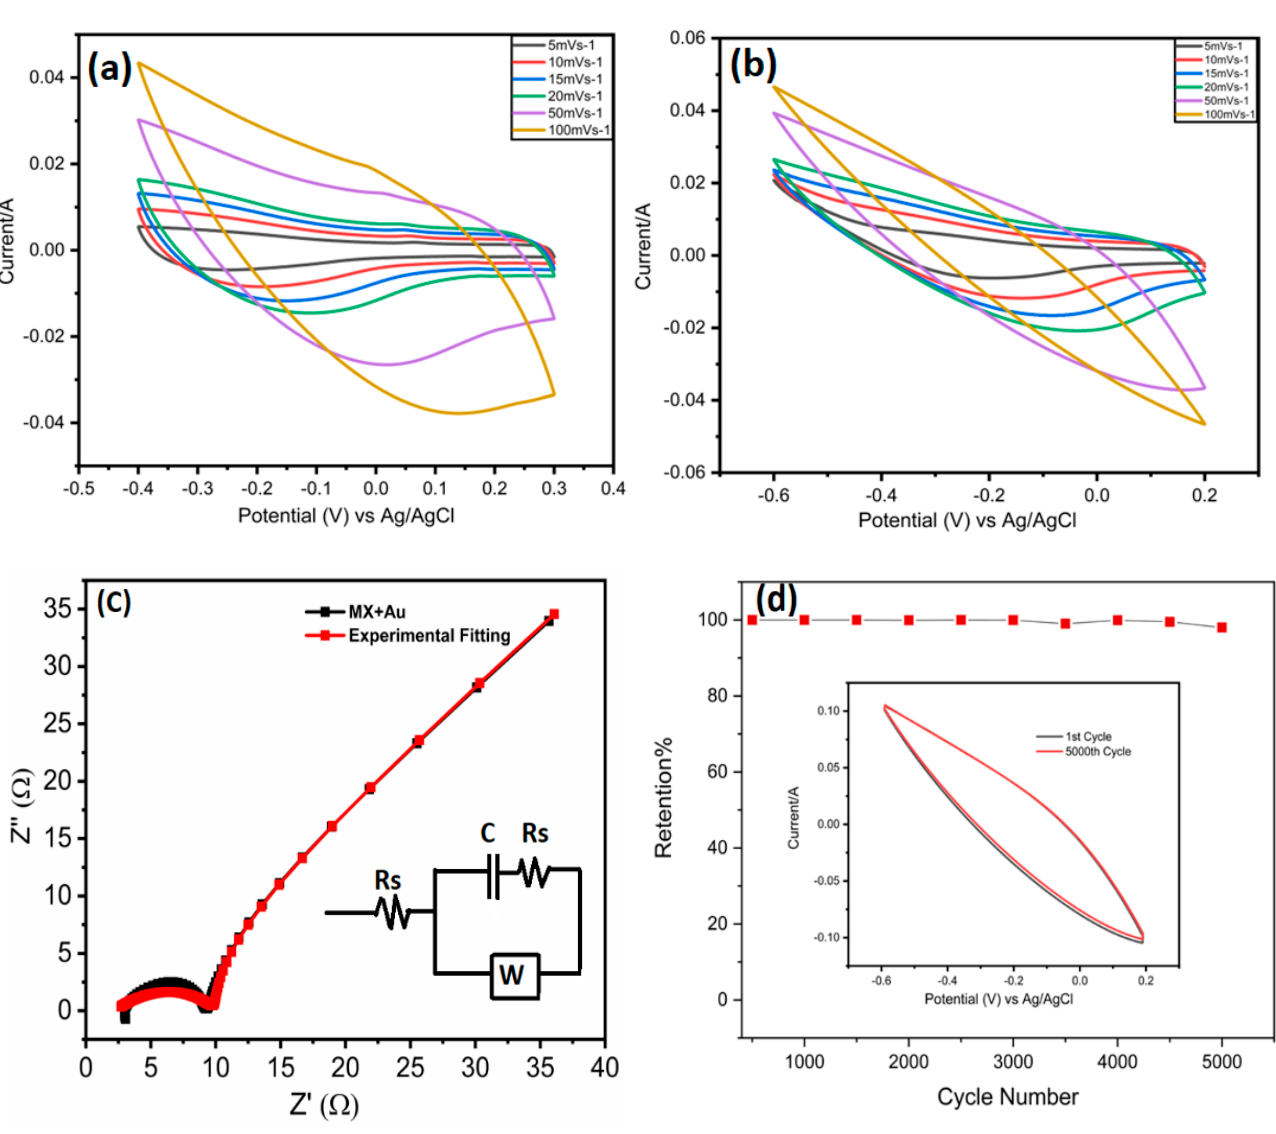
Figure 5. ( a ) CV curves of MXene at different scan rates in 3-electrode setup; ( b ) CV curves of MX/AuNPs in 1 M H 2 SO 4 at different scan rates in 3-electrode setup; ( c ) Nyquist plots of MX/AuNPs, Inset shows the equivalent circuit model for the Nyquist plots; ( d ) MX/AuNPs electrode showing excellent cyclic stability with 98% capacitance retention at 100 mVs − 1 1M H 2 SO 4 after 5000 cycles. The CV curves of pure MXene at various scan rates (5 mVs − 1 to 100 mVs − 1 ) in the voltage range of 0.3 to − 0.4 V (vs. Ag/AgCl) are shown in Figure 5a. At 5 mVs − 1 , MXene electrodes had a gravimetric capacitance of 383.5 Fg − 1 . The CV profiles did not show an- odic or cathodic peaks, indicating that the MXene’s electrochemical charge storage process could be the dominating mechanism. However, as illustrated in Figure 5b, the addition of HAuCl 4 significantly raised the MXene gravimetric capacitance by blocking MXene sheet restacking and assisting in the ion intercalation process. Therefore, the greater d-spacing can be attributed to the overall improvement in charge storage performance by minimiz- ing the restacking that would cause reversible (de)intercalation. The MX/Au electrode in three setups has been tested in 1 M H 2 SO 4 and 3 M H 2 SO 4 electrolytes (Figures 5b and 7d). The MX/Au had shown a large gravimetric specific ca- pacitance which is much higher than the pure MXene, confirming its high capacitance property. Likewise, MX/AuNPs composite electrode has a higher CV area than a pure